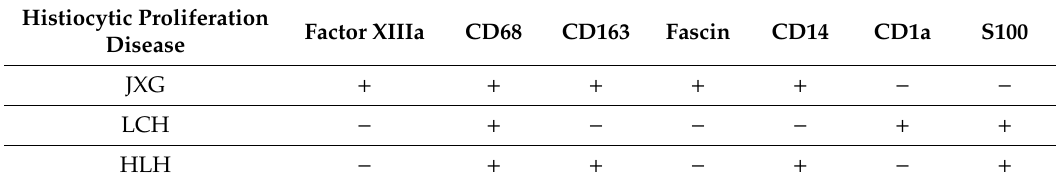
Table 2. Immunohistochemical panel used for di ff erential diagnosis between JXG, LCH and HLH. Histiocytic